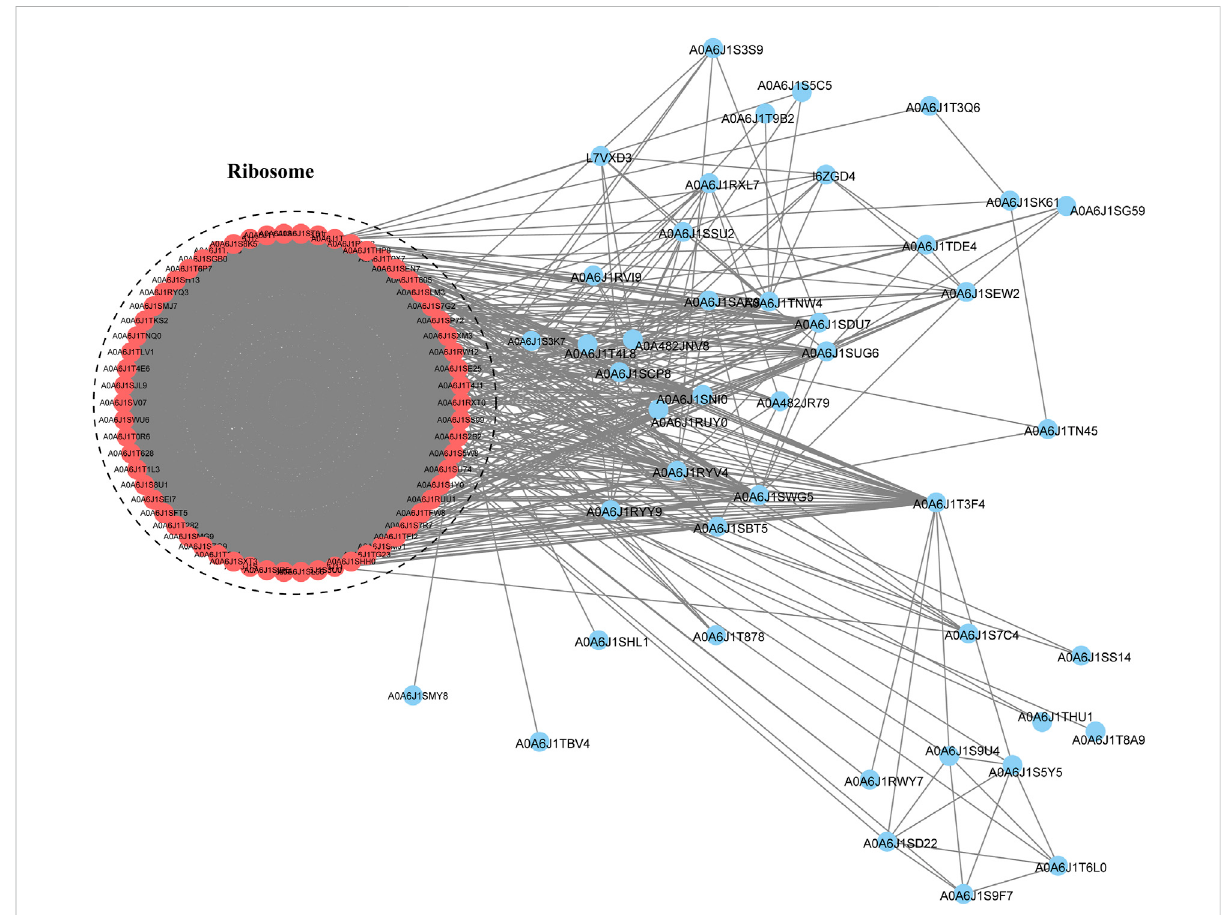
Protein-protein interaction (PPI) network analysis of Klac proteins in F. occidentalis . The interaction network of STRING was visualized in Cytoscape (version 3.3.0). The size of the nodes corresponds directly to the number of Klac sites per protein. This group of proteins was highly associated with